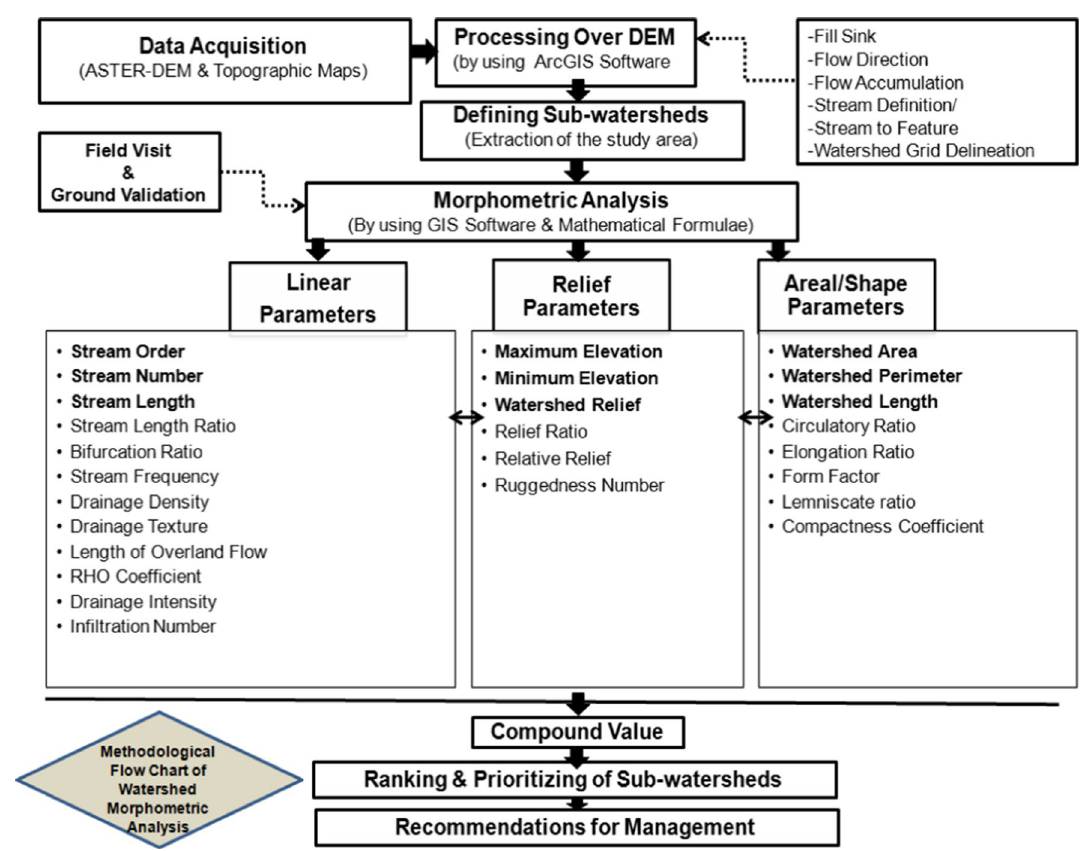
Fig. 2 Methodological flowchart for watershed morphometric